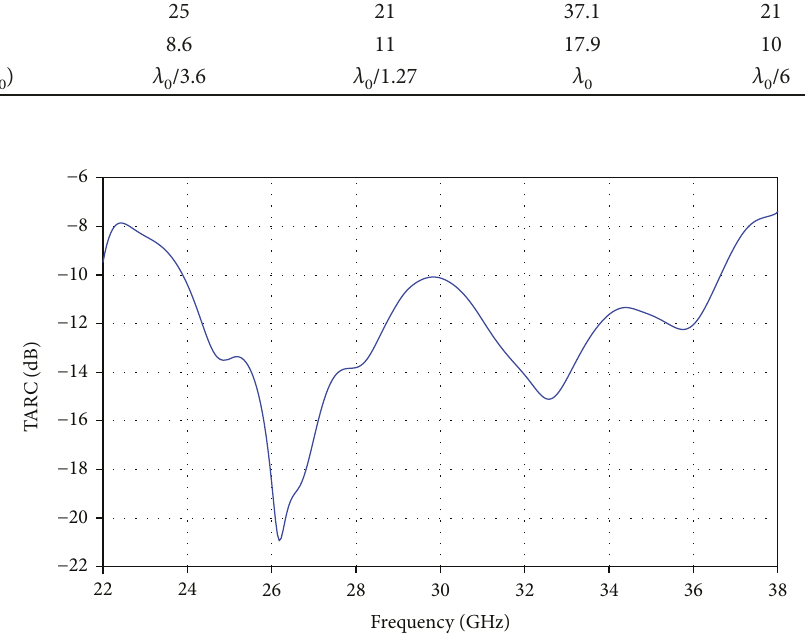
Figure 11: TARC of the proposed MIMO antenna.